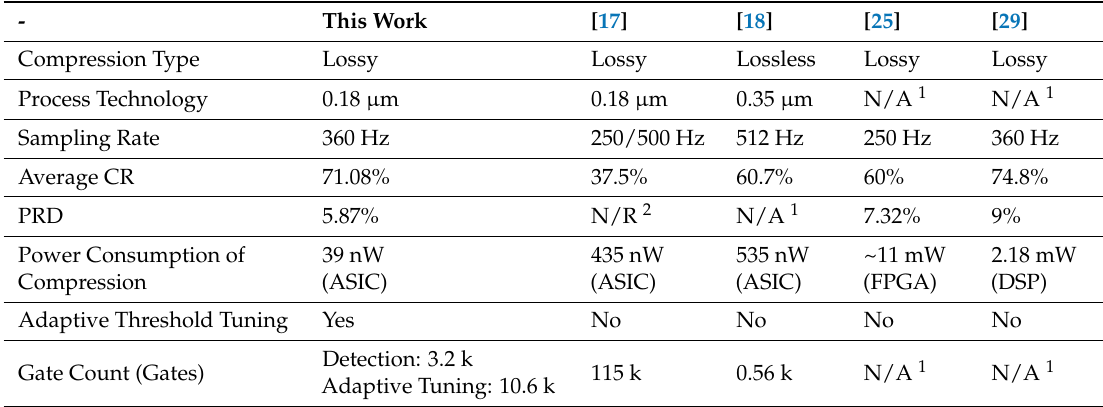
Table 1. Comparison of proposed design with other